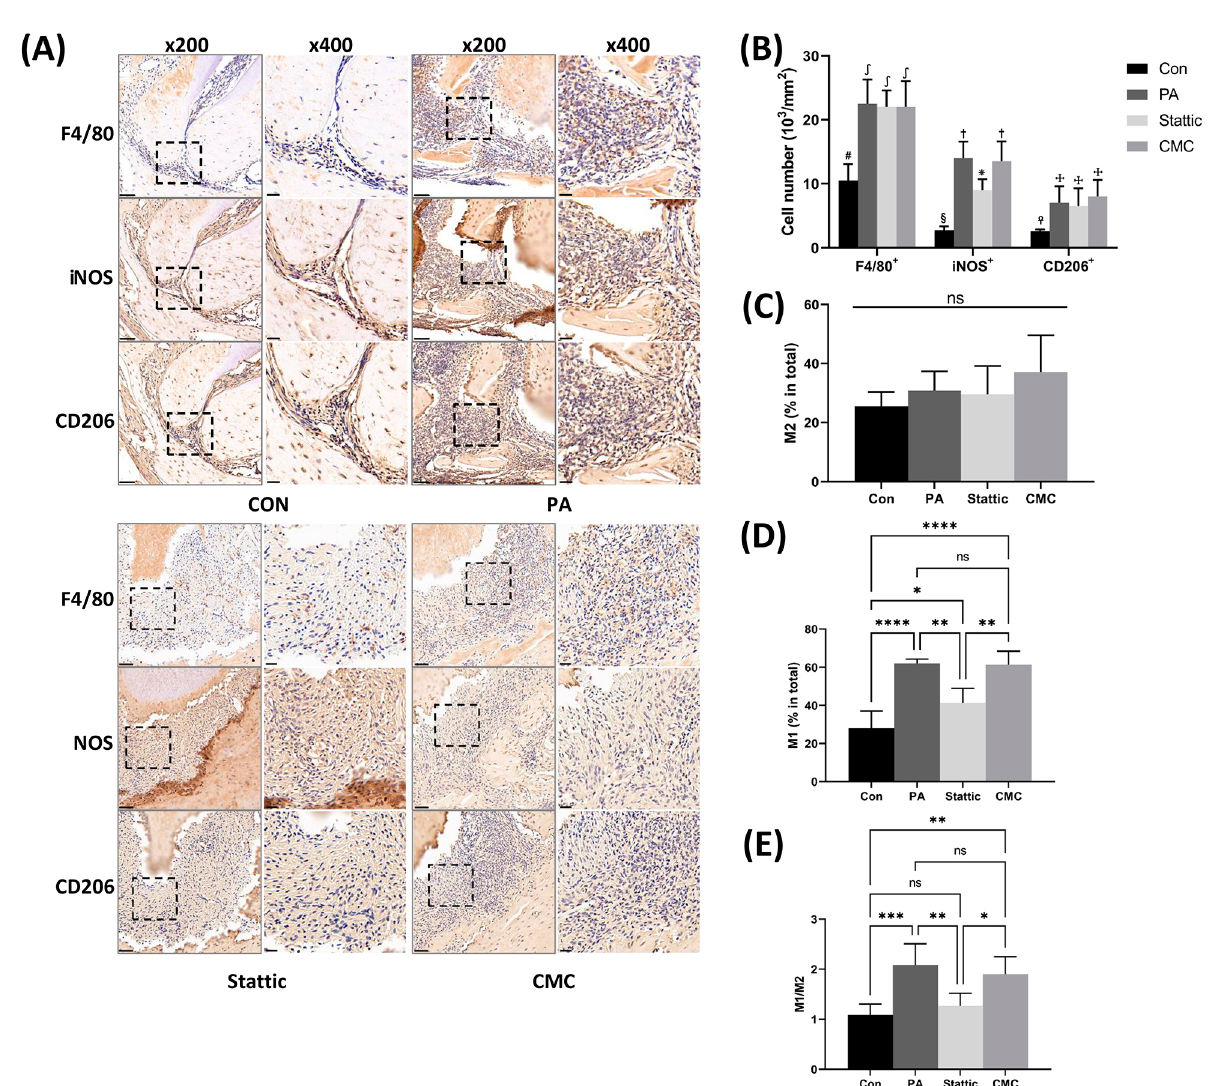
Figure 6- IHC staining of the apical regions of the mandibular first molars of the murine models. (A), representative IHC staining images of the Con, PA, Stattic, and CMC groups. Scale bars, 50 μm (×200) and 20 μm (×400), respectively. (B), statistical results for positive cell counting of the F4/80+, iNOS+, and CD206+ macrophages. Different markers on the bars indicate statistical differences. (C) and (D), percentages of the CD206+ (C) and iNOS+ (D) cells (relative to F4/80+ cells). (E) ratios of iNOS+ cells to CD206+ cells (M1/M2 ratios). Con, control group; PA, P. gingivalis -induced apical periodontitis group; Stattic, Stattic (supplemented with 0.5% carboxymethylcellulose) treatment of the AP group; CMC, 0.5% carboxymethylcellulose treatment of the AP group. *p<0.05; **p<0.01; ***p<0.001;